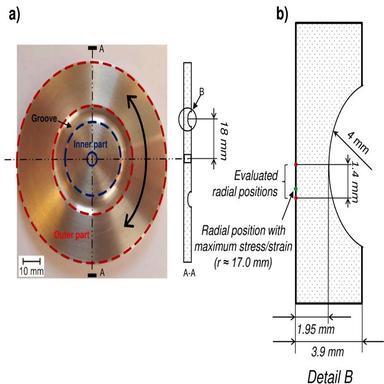
(a) grooved in-plane torsion specimen made of aluminum alloy (b) shape of the groove and evaluated radial positions for DIC measurement.